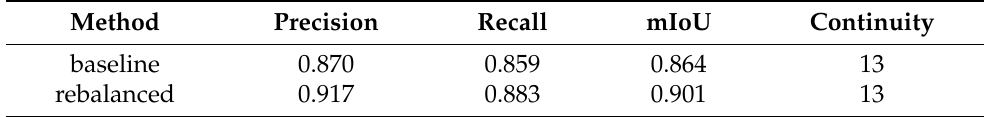
Table 4. Comparison results of rebalancing